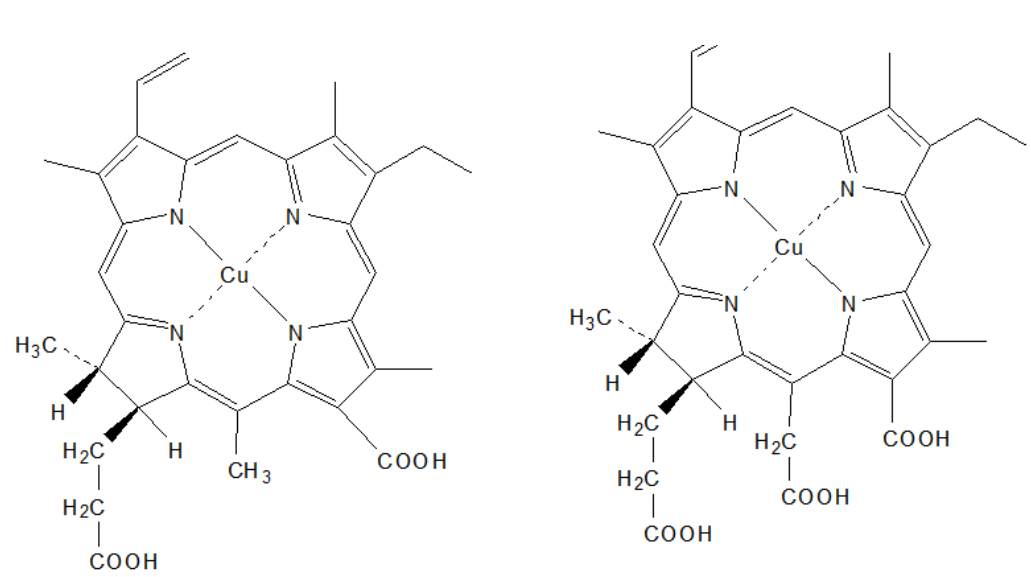
Figure 4. The structure of Cu(II)chlorin e 4 (left) and Cu(II)chlorin e 6 (right)